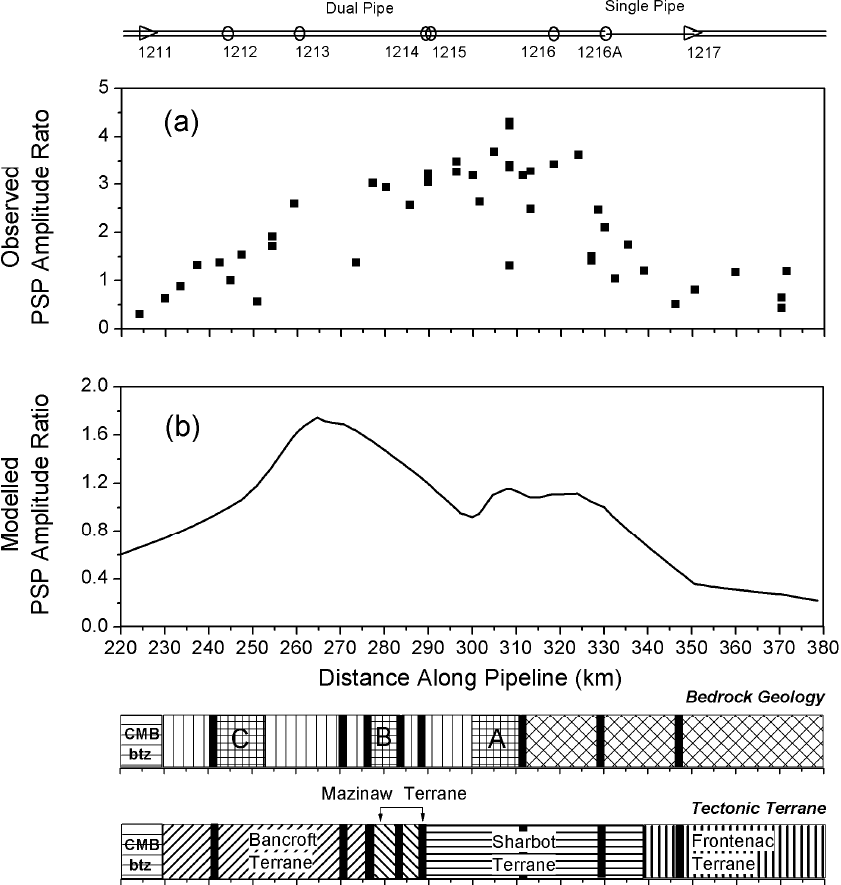
Figure 10. Fig. 10. Comparison of observed PSP amplitude ratio (a) and the Case 4 modelled PSP amplitude ratio (b) variations along the pipeline. Schematic representation of pipeline structure shown at top of figure (see Fig. 5 for key). Schematic representation of bedrock geology (see Fig. 7 for key) and tectonic terrane along the pipeline route are shown at bottom of